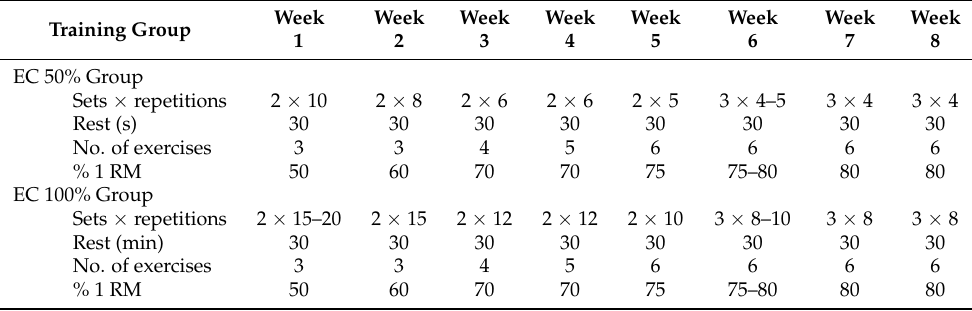
Table 2. Progression of resistance training throughout the 8-week training intervention.